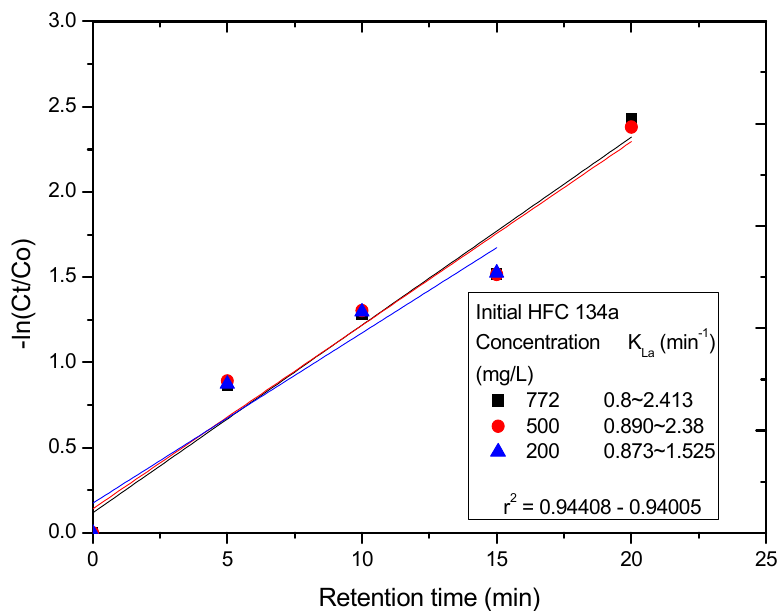
Figure 3. Effect of the initial HFC-134a concentration on the K L a . (Liquid circulation rate: 80 L/min, air flow rate: 10 L/min).